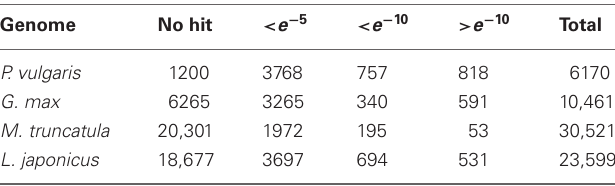
Table 5 | Frequency of potential sORFs sharing domains with larger polypeptides of the same